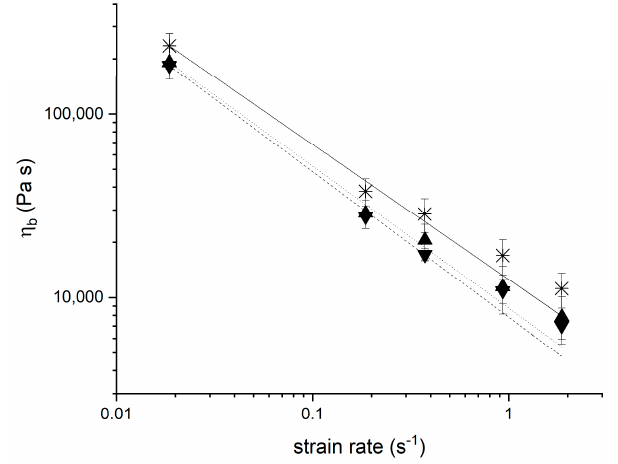
Figure 2. Extensional viscosity measured at ε b = 1.00 after 3 h fermentation at 30 °C presented as flow curve. Data were fitted according to Turbin-Orger et al. (2015) using a power law model . ( n − 1 ) (cid:0) . (cid:1) = K · ε ε ( η b ). ( ― ― ) Reference without additives, (·· ▲ ··) 1 g yeast/100 g flour, (-- ▼ --) 2 g yeast/100 g flour. (n = 3, X ± STD).